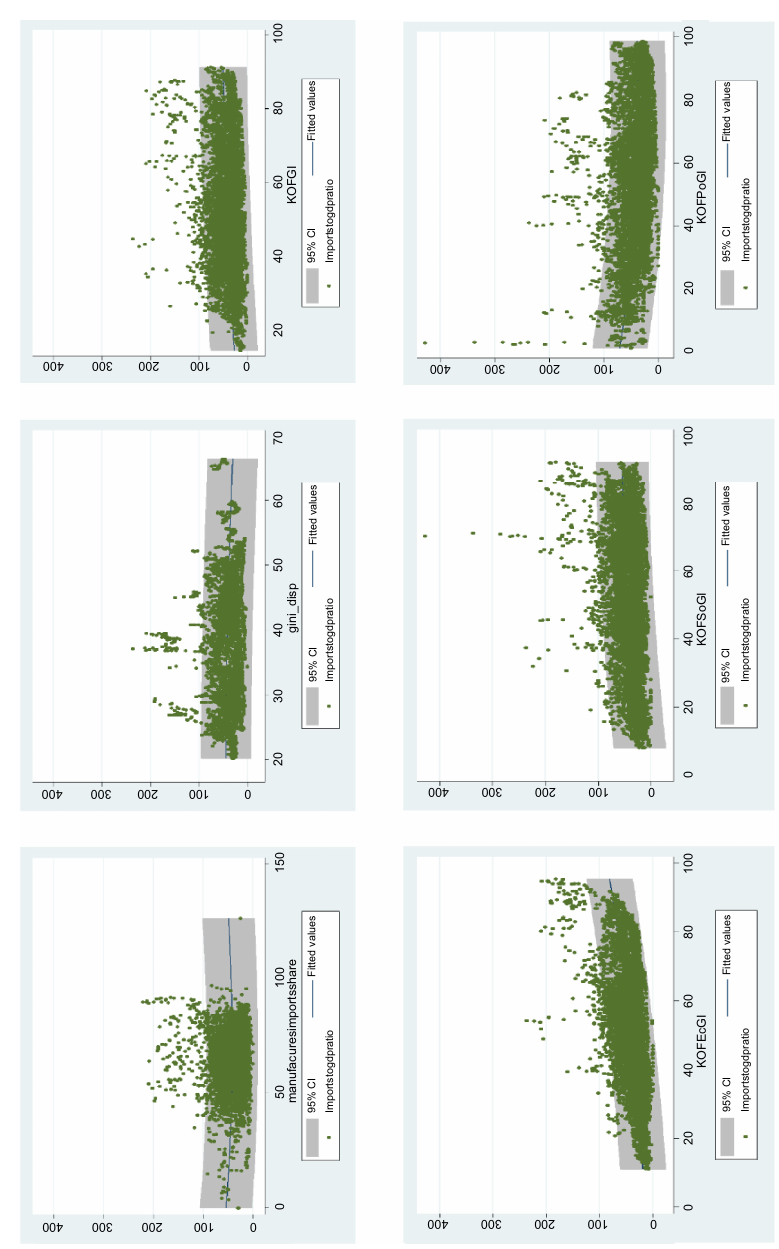
Figure 7. Scatter plots and OLS fitted